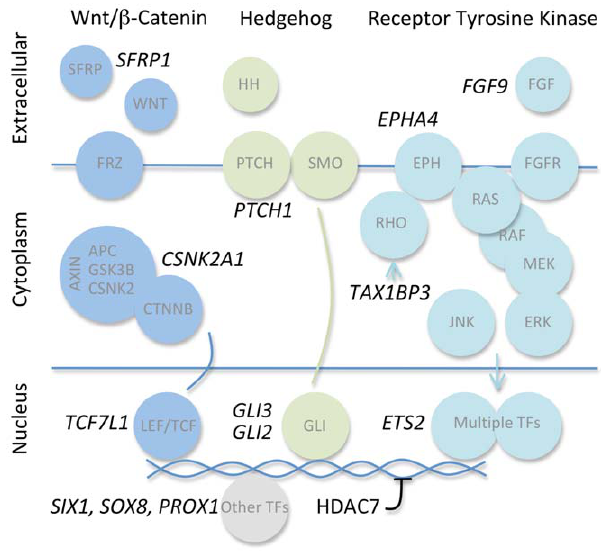
Figure 2. Pathway assignment of genes that scored positive in the RNA interference phenotypic screen. Gene symbols of positives are given in black letters, associated key pathway components are given in grey letters, displayed in colored circles and ordered by cellular compartment. Blue: Wnt pathway, Green: Hedgehog pathway, Cyan: RTK pathways. Genes were assigned to pathways using literature, Gene ontology and other database searches. Key references are given in the main